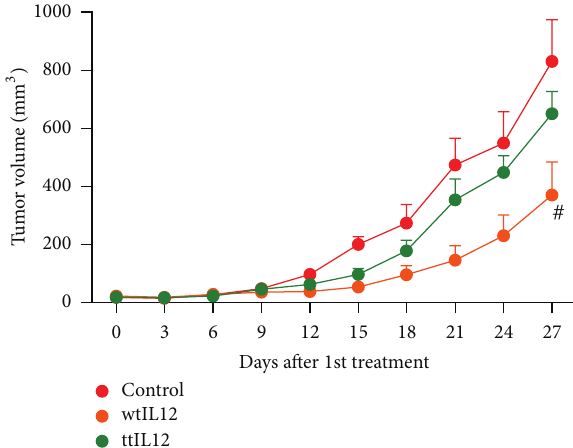
Figure 6: Increasing the dose of ttIL12 pDNA abrogates its thera- peutic benefits. Increasing the dose by 3-fold to 30 𝜇 g pDNA per treatment resulted in a loss of inhibition by ttIL12 pDNA treatments, while the wtDNA treatments retained the ability to inhibit primary tumor growth in 4T1 primary tumor growth. Black arrows represent treatments. # represents 𝑃 < 0.05 compared to all other